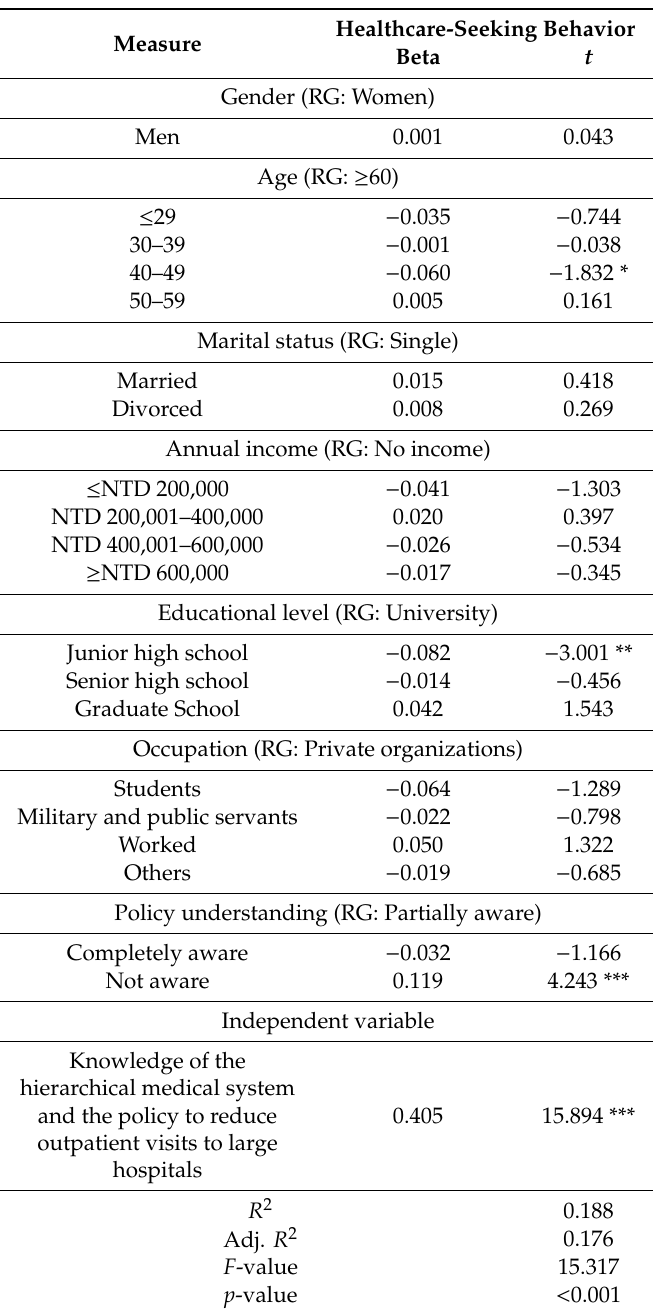
Table 2. Multiple regression estimates for healthcare-seeking